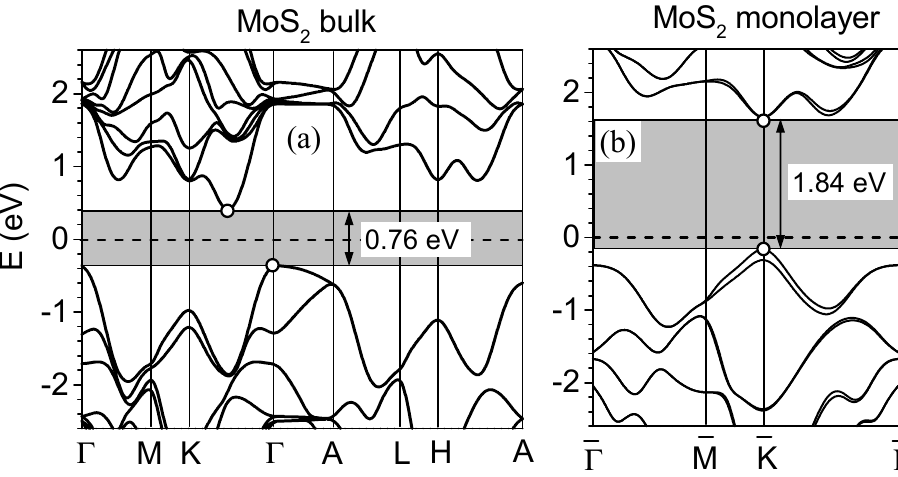
Figure 4. The band structures of the ( a ) bulk MoS 2 and ( b ) MoS 2 monolayer calculated within LDA in a fully relativistic (i.e., with account for spin-orbit coupling) approximation. Shaded areas denote the band gaps. Valence band maxima and conduction band minima are marked by circles.